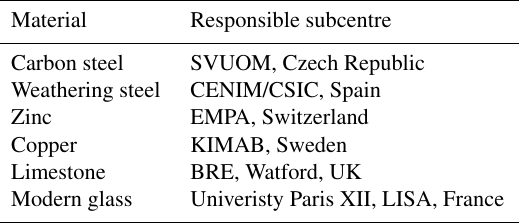
Table 1. Responsible subcentres for the evaluation of corrosion or soiling of the exposed materials for the period 2011–2012.